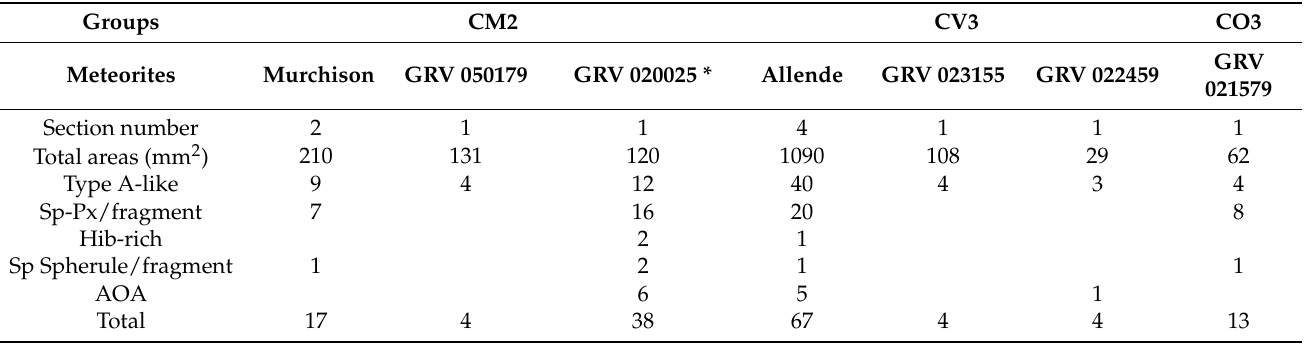
Table 4. Summary and comparison of Ca, Al-rich refractory inclusions and AOAs in GRV